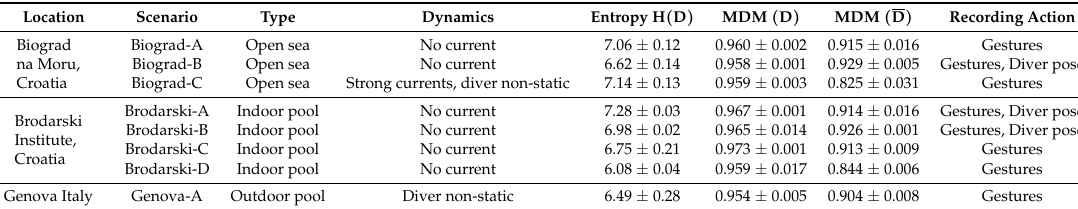
Table 1. Description of the different dataset recording scenarios.